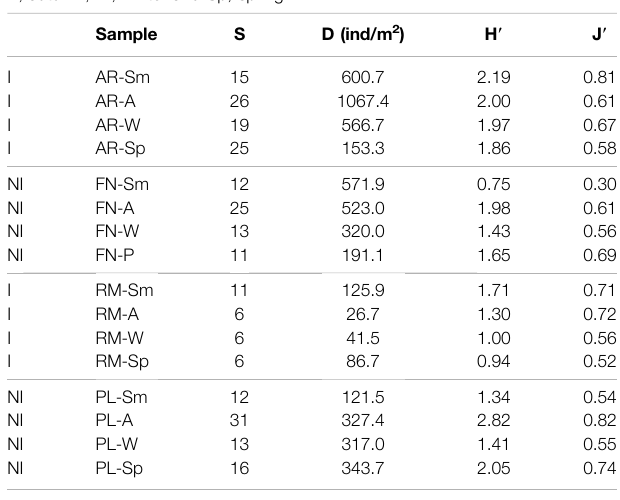
TABLE 3 | Diversity index of macroinvertebrate of river (AR, Arroyito; FN, Fortín Nogueira) and reservoir (RM, Ezequiel Ramos Mexía; PL, Pichi Picún Leufú) sitesofLimayRiver,Patagonia.S,speciesrichness;D,density;H ′ ,Shannonindex and J ′ , Pielou evenness index; I, invaded and NI, not invaded sites; Sm, summer; A, autumn; W, winter and Sp, spring.